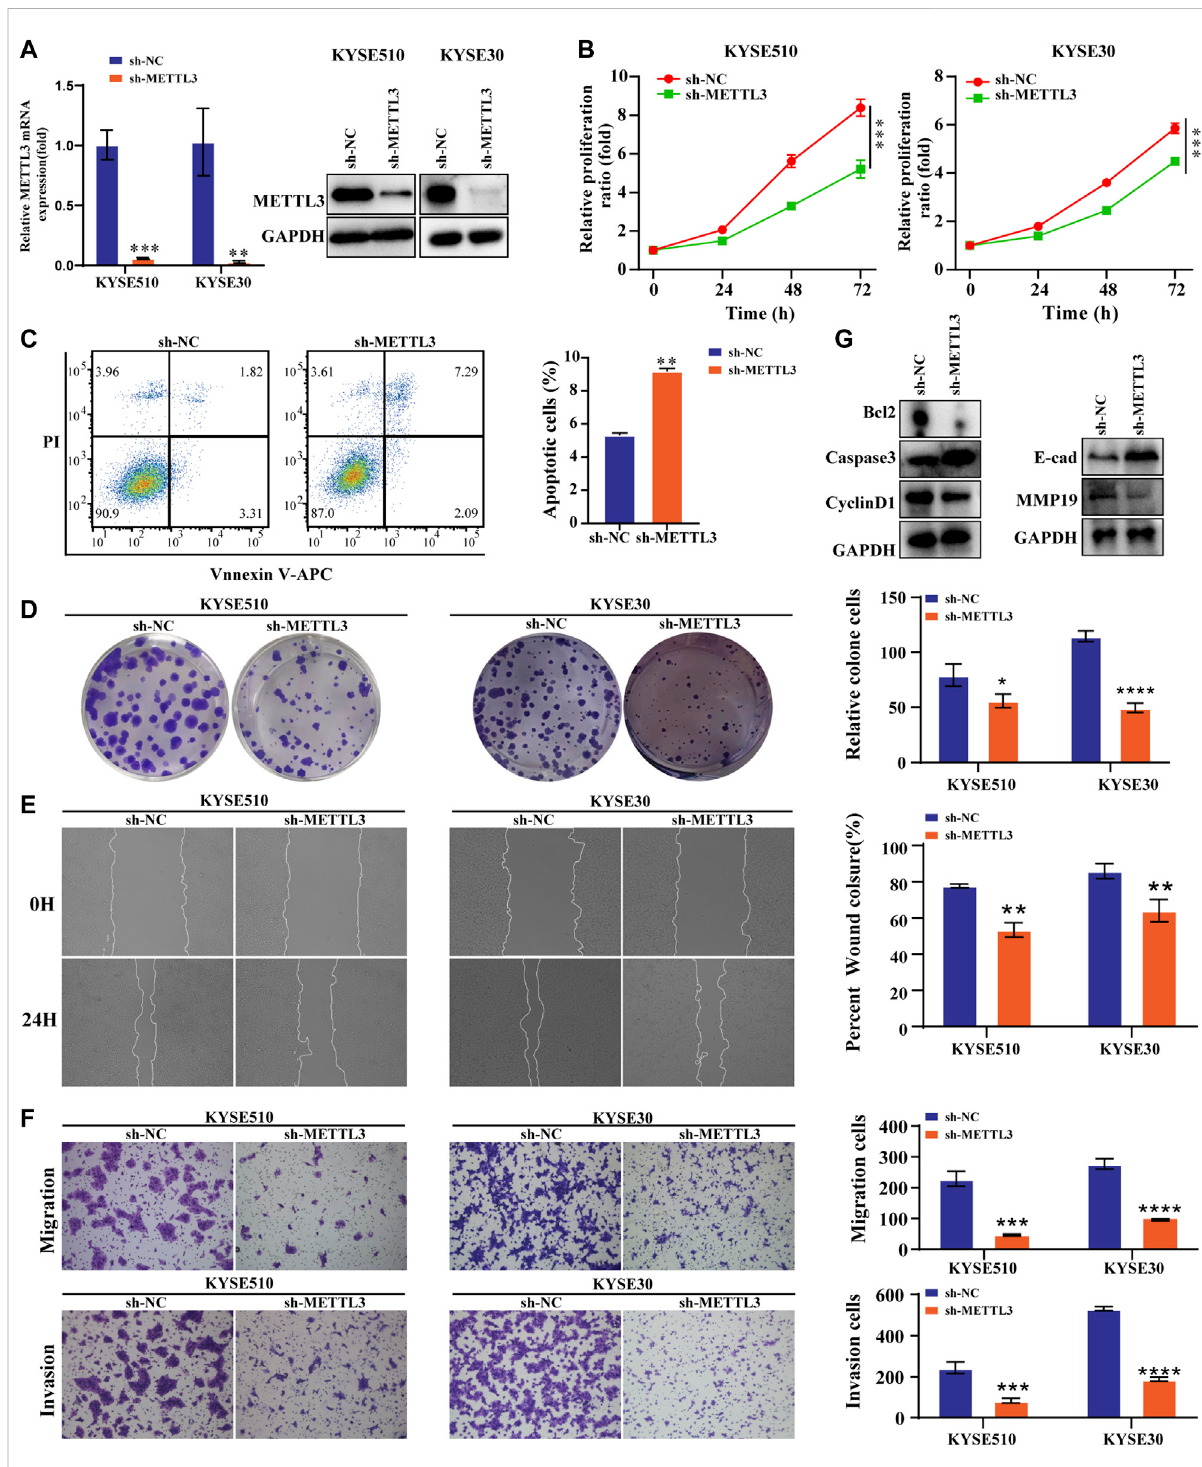
Low METTL3 expression is associated with proliferation, apoptosis, migration and invasion in ESCC cells (A) . The mRNA and protein levels of METTL3 were drastically decreased following lentiviral transfection of KYSE510 and KYSE30 cells. (B) . The CCK-8 assay assessed the proliferation ability of METTL3-knockdown cells. (C) . Flow cytometric analysis wasconductedto assessapoptosis inKYSE510 METTL3-knockdown cells. (D) .The clonality of KYSE510 and KYSE30 cells was measured by the plate clone. (E) . The wound scratch test and (F) . Transwell migration and invasion assays were conducted to examine the migratory and invasion capacities of METTL3 knockdown cells. (G) . Expression of E-cadherin and MMP19 proteins was detected via western transfer in METTL3-knockdown cells. The protein levels of Bcl2, Caspase 3 and Cyclin D1 were detected